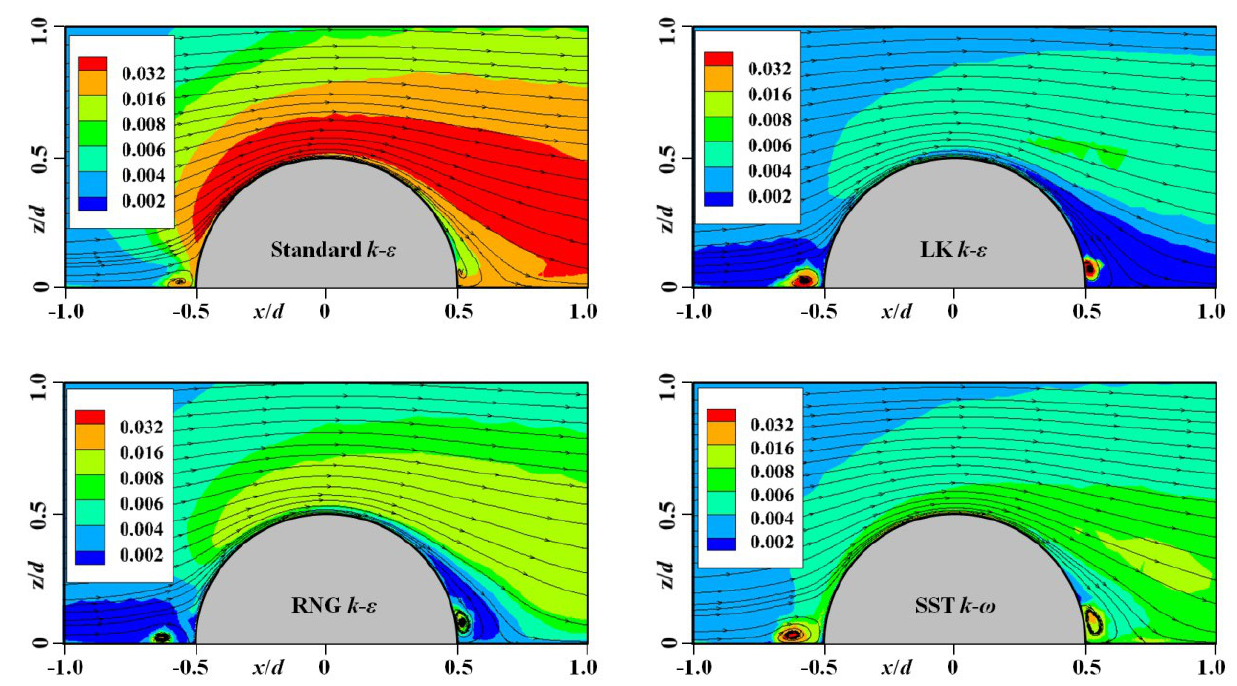
Figure 2. Comparisons of mean streamlines and normalised turbulent kinetic energy obtained with the adopted models in the centre plane of the domain.